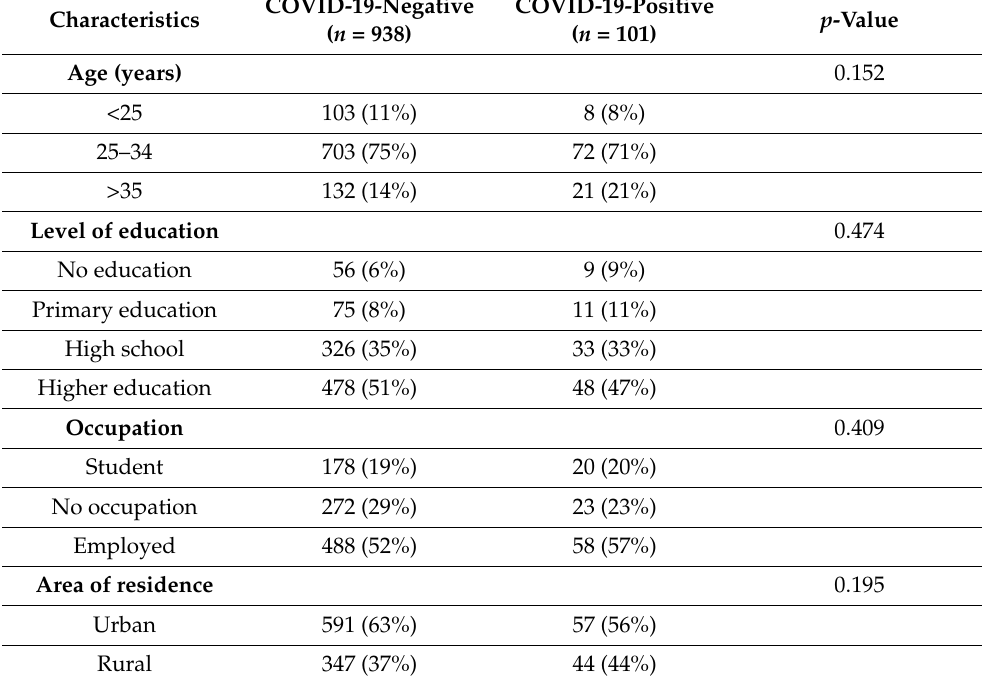
Table 1. Maternal general characteristics.